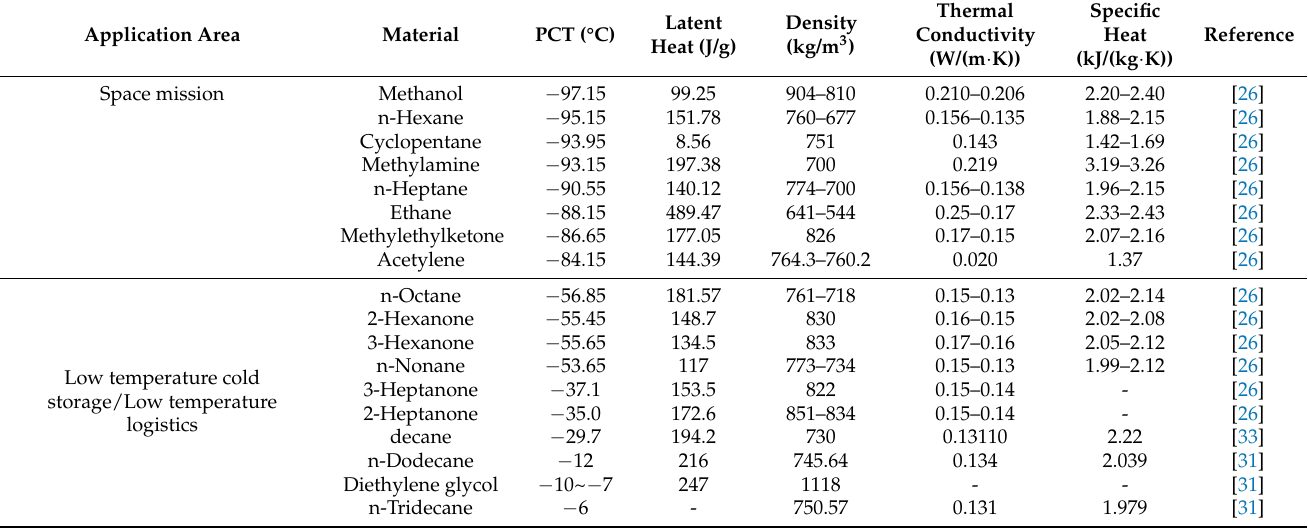
Table 1. Typical organic PCMs for